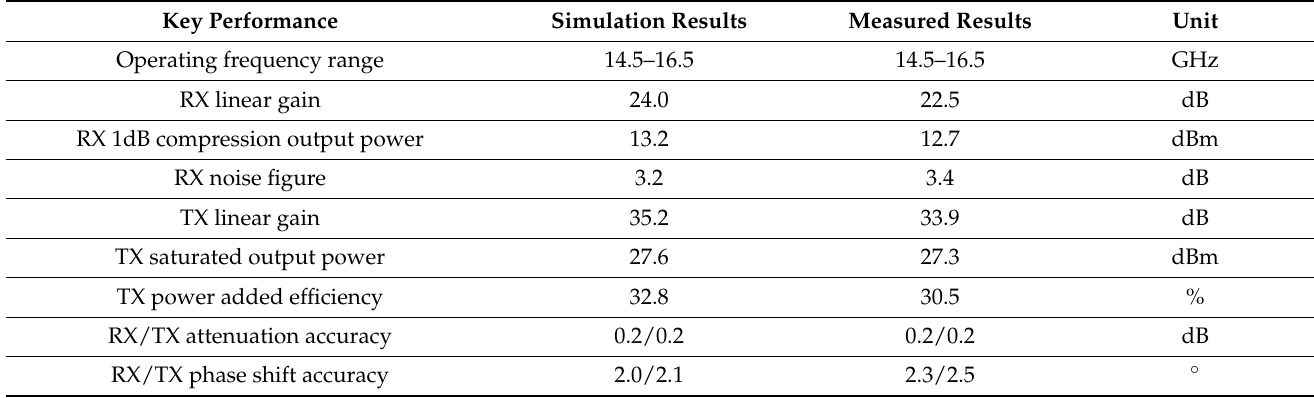
Table 2. Measured results of the SIP’s key performance in receiver (RX) and transmitter (TX)